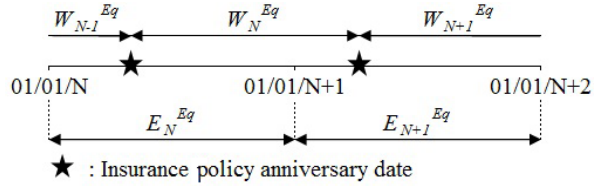
Figure 2. Illustration of the difference between the earned and the written premium